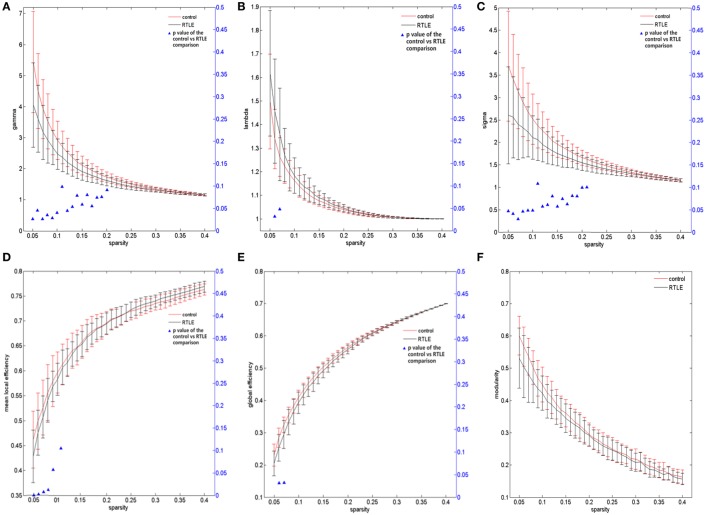
Functional connectivity network at different sparsity for right temporal lobe epilepsy (rTLE) patients (the black line) and controls (the red line) and their statistical comparison results (ANCOVA). (A) Gamma, (B) lambda, (C) sigma, (D) mean local efficiency, (E) global efficiency, (F) modularity. Error bars indicate standard error within each group at each threshold value. The blue triangles display the (ANCOVA) p-values.